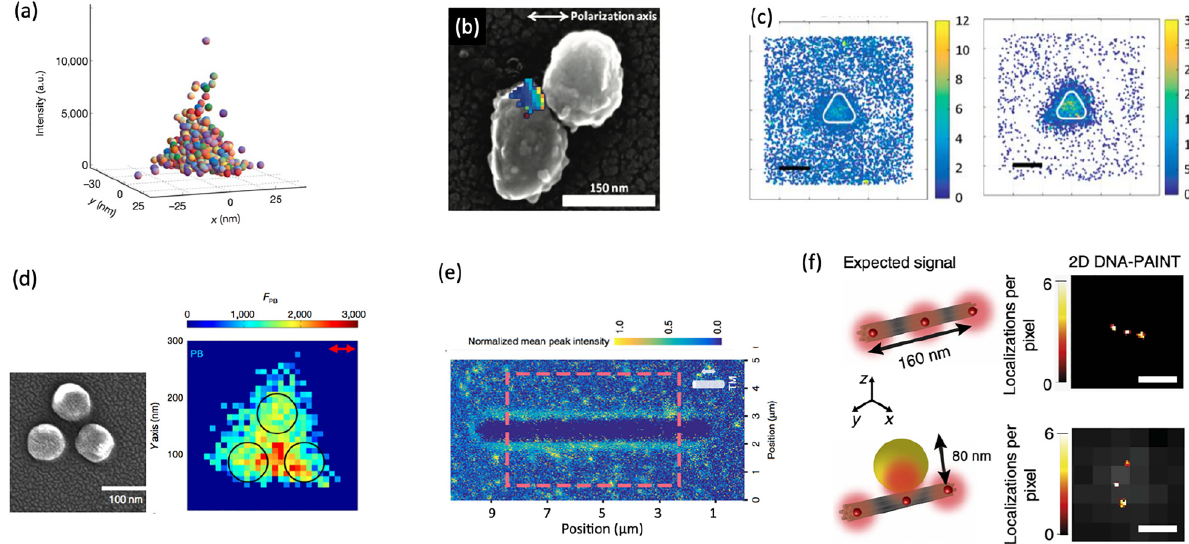
Figure 5: Intensity-based single-molecule experiments to study light-matter interaction at the nanoscale. (a) Super-resolved image of a hotspot on an aluminum film. Each dot indicates a single molecule detection. Adapted from [117]; (b) correlation between the SEM image and super-resolved fluorescence image of a colloidal silver structure for SERS. Adapted from [118]; (c) mapping of the fluorescence intensity of single molecules in the near-field of a nanotriangle for out-of-resonance (left) and in-resonance (right) conditions. Adapted from [122]; (d) SEM image of a three aluminum nanodiscs arranged on the apex of a triangle. Corresponding fluorescence intensity map obtained by single-molecule imaging of single molecules adsorbing at the surface of the structure. Adapted from [123]; (e) normalized intensity map for single molecules adsorbing to the surface of a 75 nm diameter silicon nanowire. Adapted from [124]; (f) DNA-PAINT image of three binding sites located at a distance of 80 nm one to the other in the presence (bottom) and in the absence (top) of a gold nanosphere. Adapted from